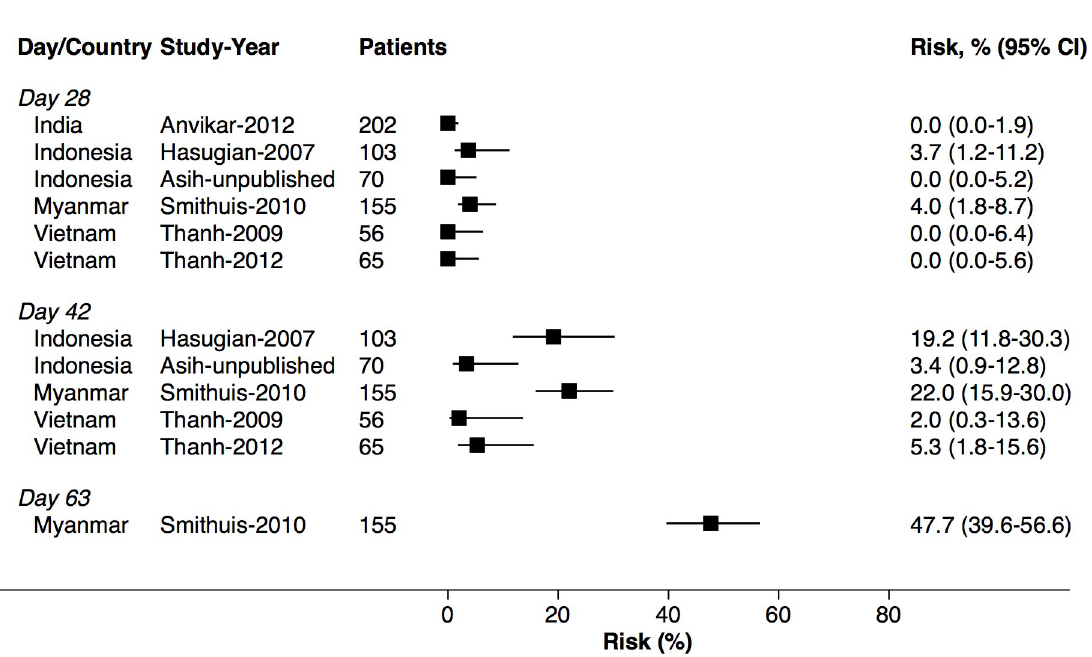
Fig 4. Cumulative risk (Kaplan–Meier analysis) of P . vivax parasitaemia after P . falciparum infection by study for AA. AA, artesunate-amodiaquine.